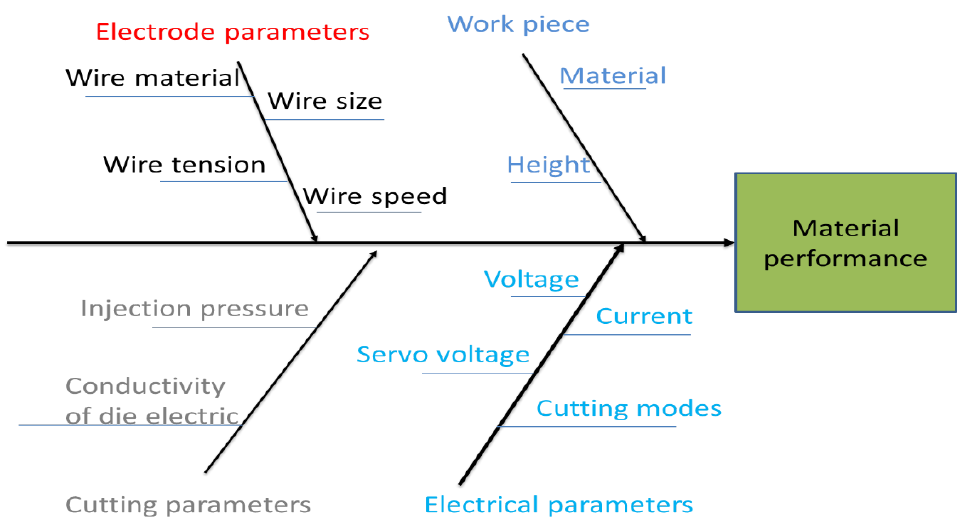
Figure 1. Ishikawa Cause and Effect Diagram for WEDM Process [15].